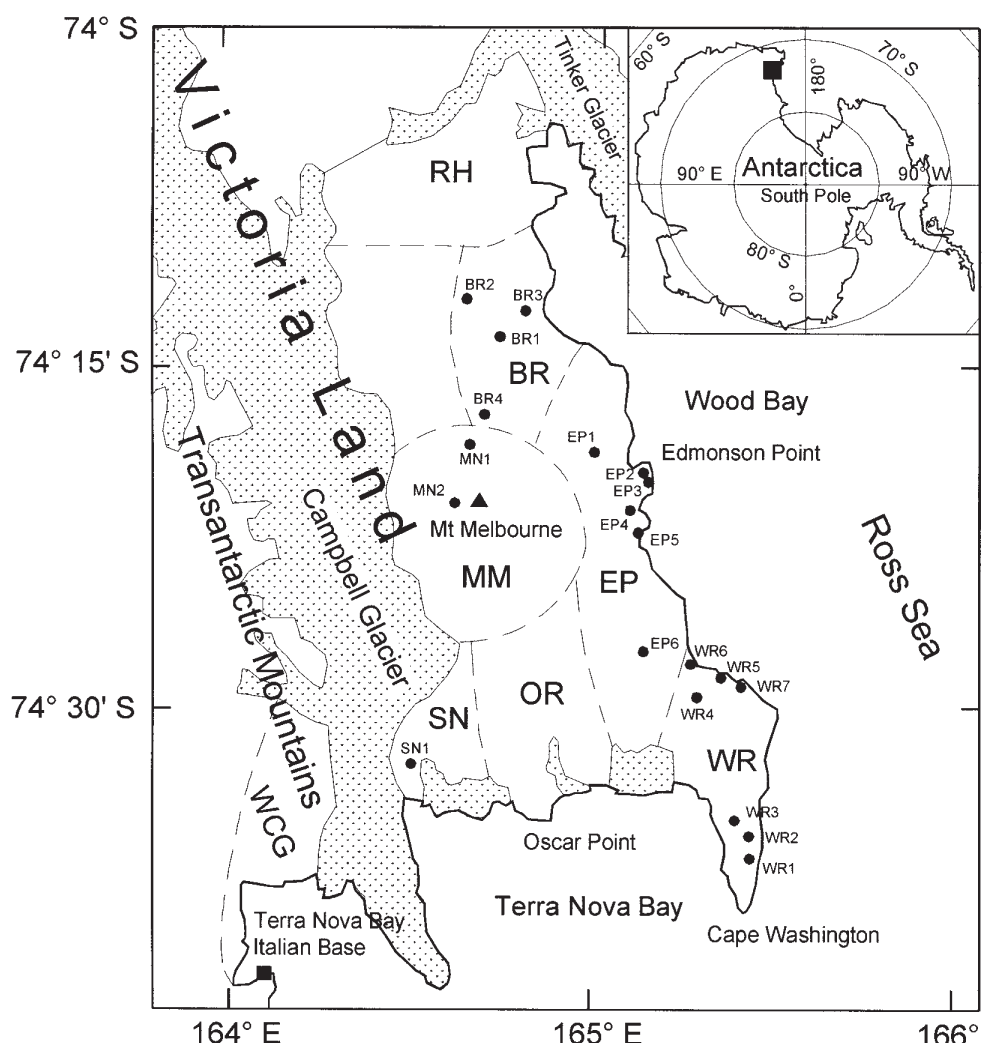
Fig. 1. Sketch map of the Mt Melbourne Volcanic Field showing position of sampling sites (see table I for sam- ple codes and types of rocks). Sub-fields: WCG – West of Campbell Glacier, SN – Shield Nunatak, OR – Oscar Ridge, WR – Washington Ridge, EP – Edmonson Point, BR – Baker Rocks, RH – Random Hills, MM – Mt Mel- bourne